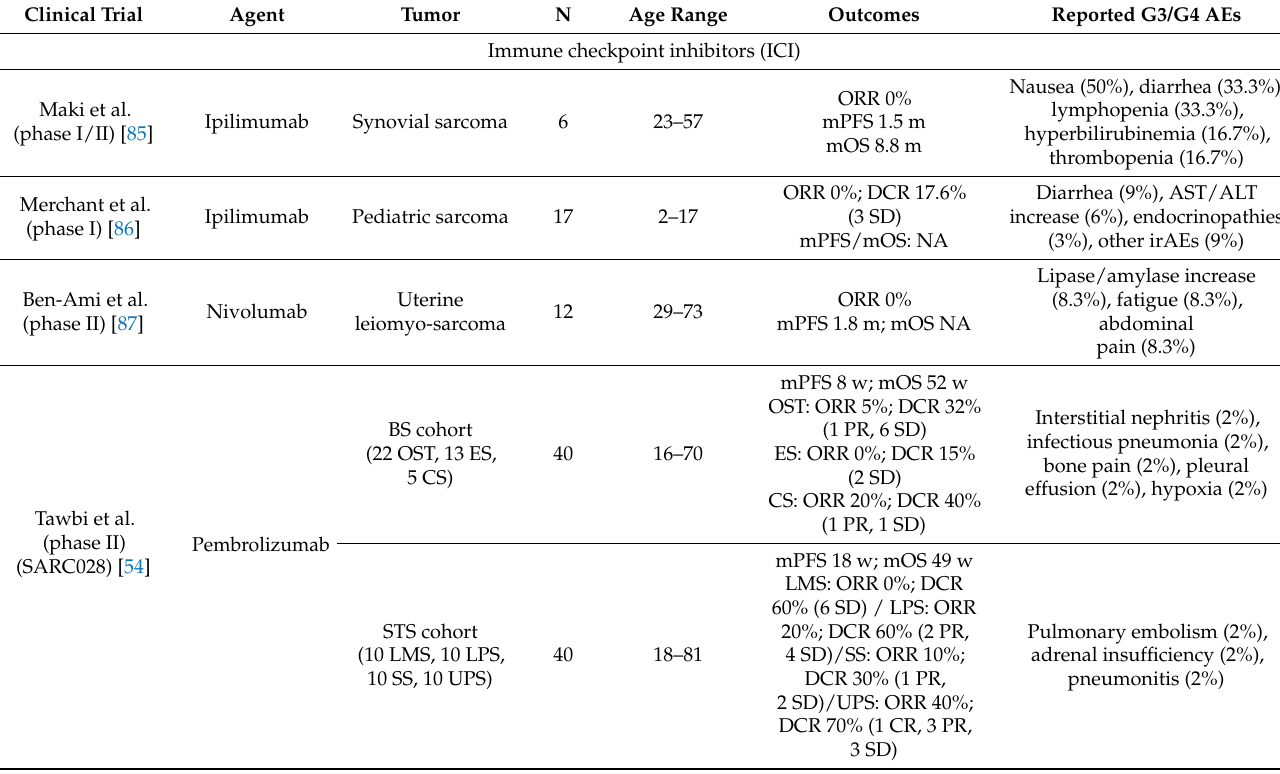
Table 1. Published results of immunotherapy in sarcoma. AEs: adverse effects; irAEs: